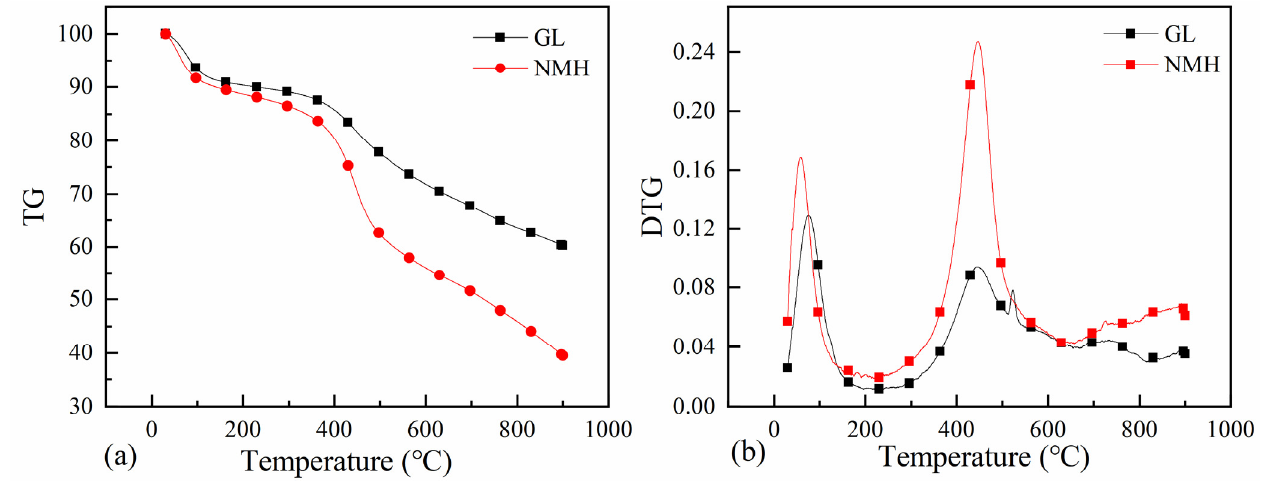
Figure 5. Pyrolysis behavior NMH and GL raw coal in TG ( a ) and DTG ( b ).